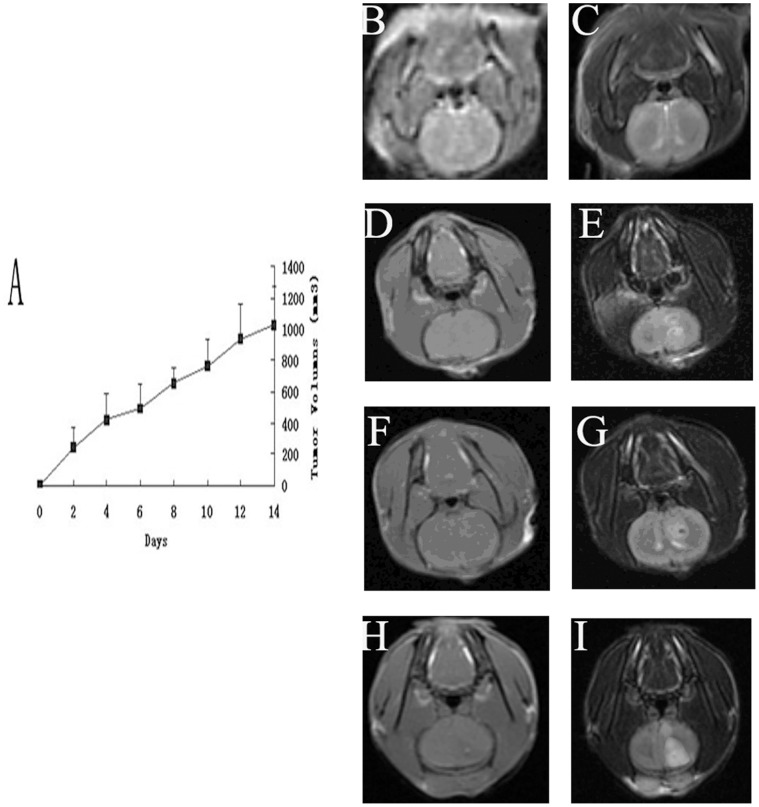
Volumes of brain glioma calculated by MRI scan.A Curve shows the volume of tumors on different days after transplantation. B, D, F, and H are images of T1 weighted signal. C, E, G, and I are images of T2 weighted signal. First day (B and C), 5 days (D and E), 10 days (F and G) and 14 days (H and I) after transplantation are shown.